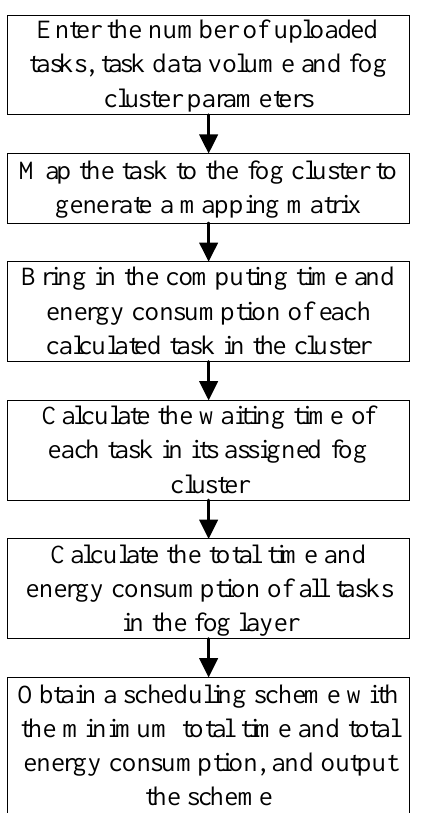
Figure 4. Task-scheduling process between fog clusters.